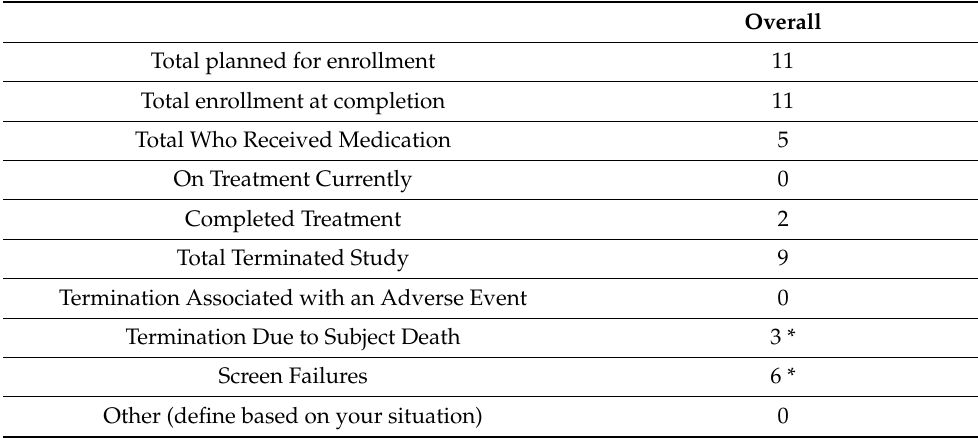
Table 5. Status of Enrolled Participants.